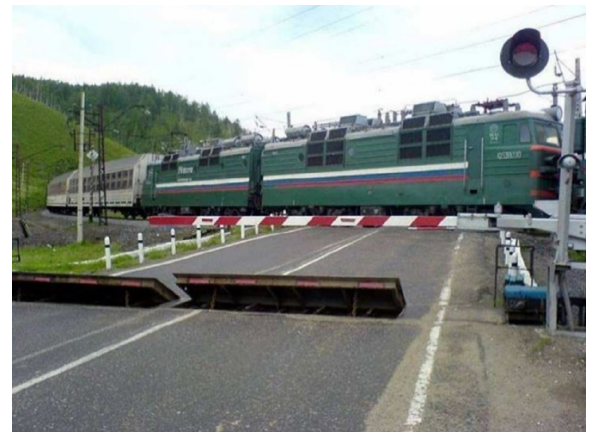
Figure 6. Railway crossings in Russia Federation [4].